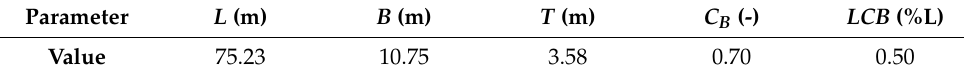
Table 1. The input parameters of the Series 60 ship adopted in this study.